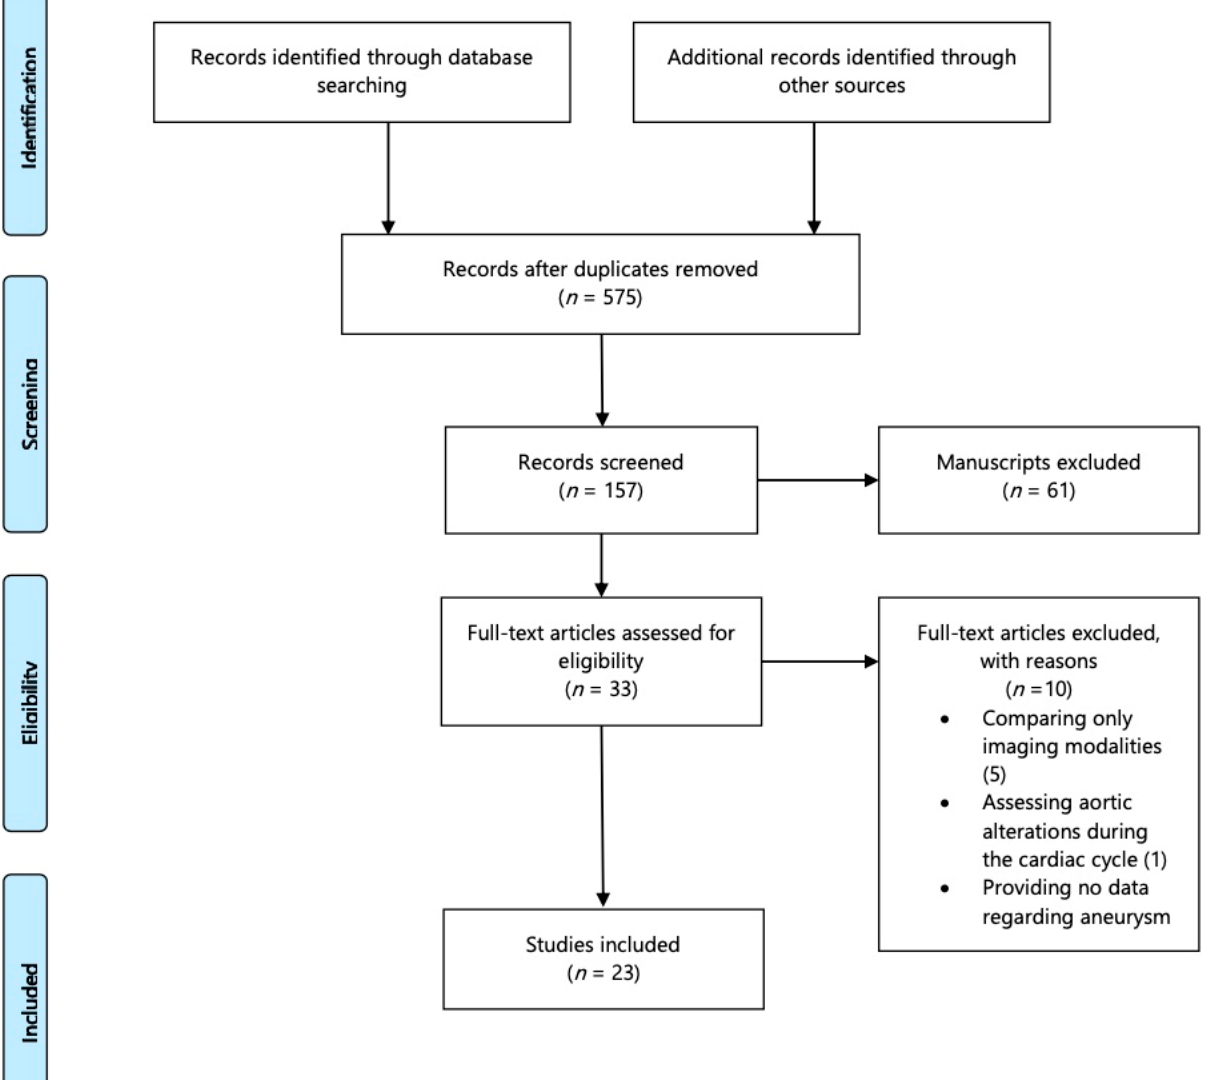
Figure 1. The flow chart of the selection process according to Systematic Reviews and Meta-Analysis statement [13]. Table 2. Retrospective and 10 prospective. All patients underwent imaging with different modalities; the initial evaluation was followed by one or more studies to assess AAA (abdominal aortic aneurysm) expansion. Different modalities were applied including CTA, MRI, PET and US or a combination of them.